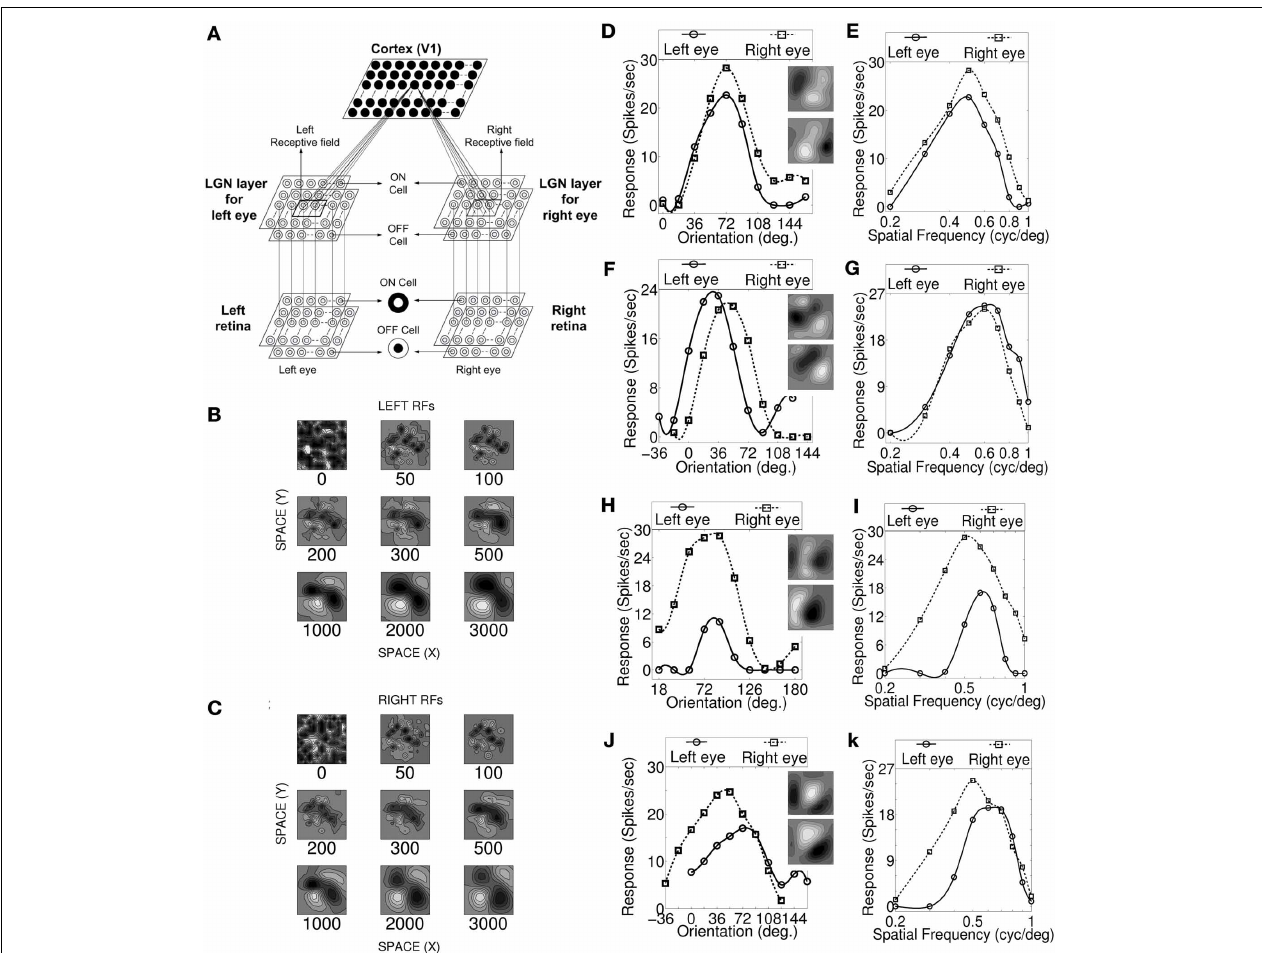
FIGURE 1 | Visual pathway model, RF development, OR and SF tuning curves. (A) Three layer visual pathway model consists of (1) Layer 1: left and right retina/eye (each M × M overlapping ON and OFF retinal cells), (2) Layer 2: left and right eye specific LGN layers (each M × M overlapping ON and OFF LGN cells), and (3) Layer 3: layer IV of V1 in cat ( N × N cortical cells). Each cortical cell in the model receives thalamic projections from 13 × 13 left and right eye specific LGN cells centered at their retinotopic center. These thalamocortical connections define left and right RFs. (B,C) The snap shots of the left and the right RF of a sample cell at different stages of development. The ON and OFF subregions are shown in gray scale with white (black) color representing strong synaptic connection from ON (OFF) LGN cells. The